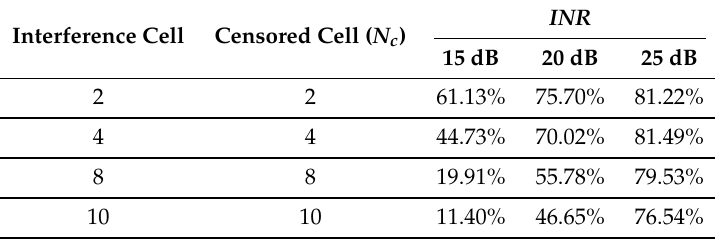
Table 3. Probability P censor that the exact number of interference targets has been